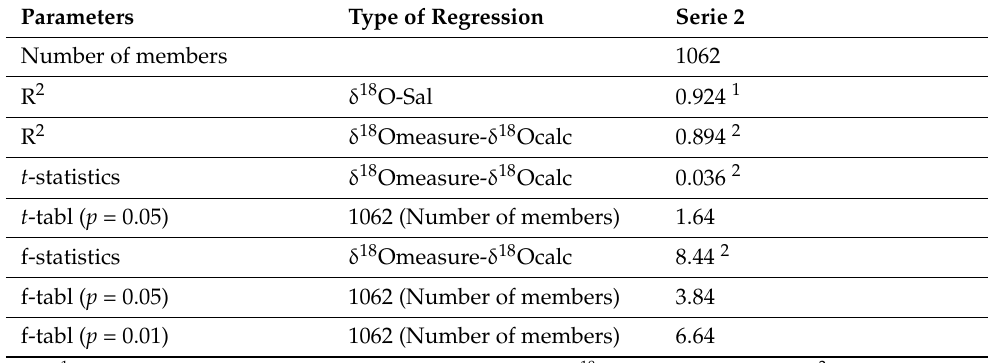
Table A1. The calculated regression line, the used statistical test and the significance